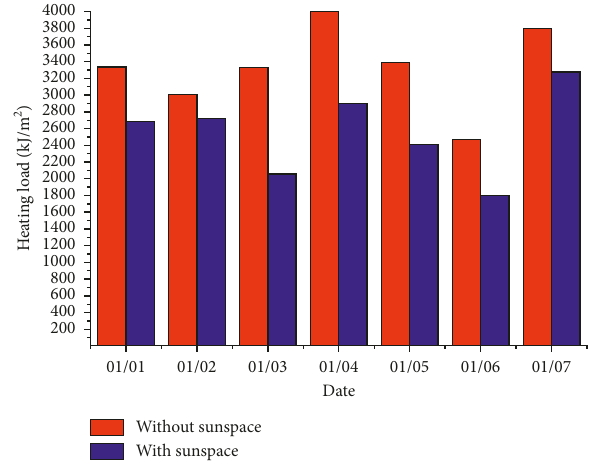
Figure 21: Heating load comparison with and without sunspace mode (source: authors’ own